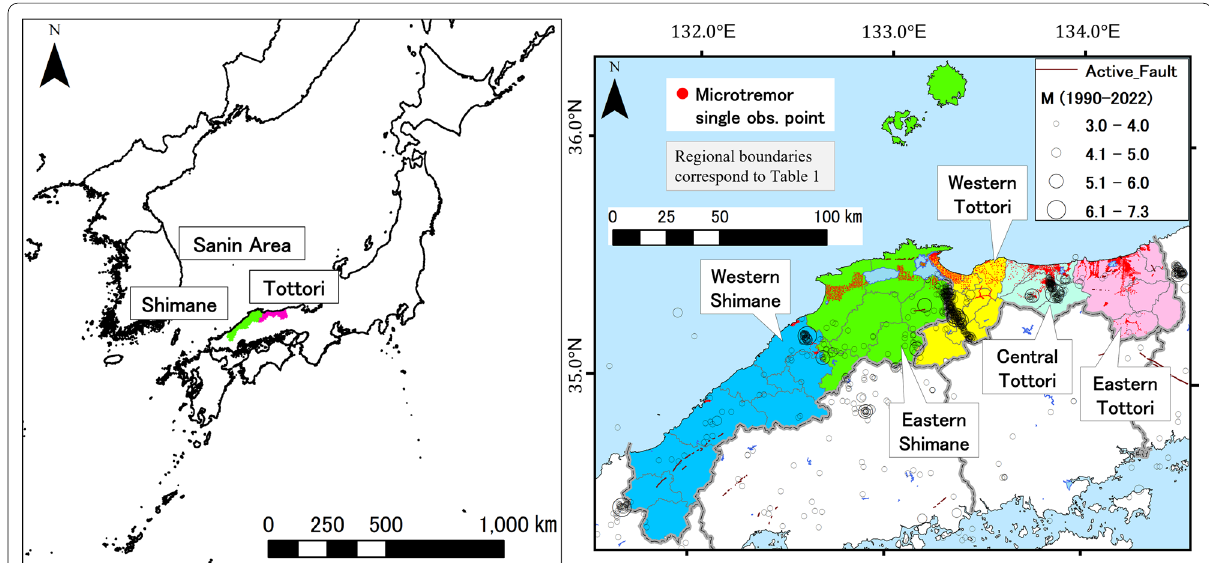
Fig. 1 Location of the San’in region (left map) and each region are shown in Table 1 (right map). The right map also shows the location of active faults, the distribution of epicenters of magnitude 3 or greater from January 1, 1990 to May 31, 2022 and the location of single-point observation sites for